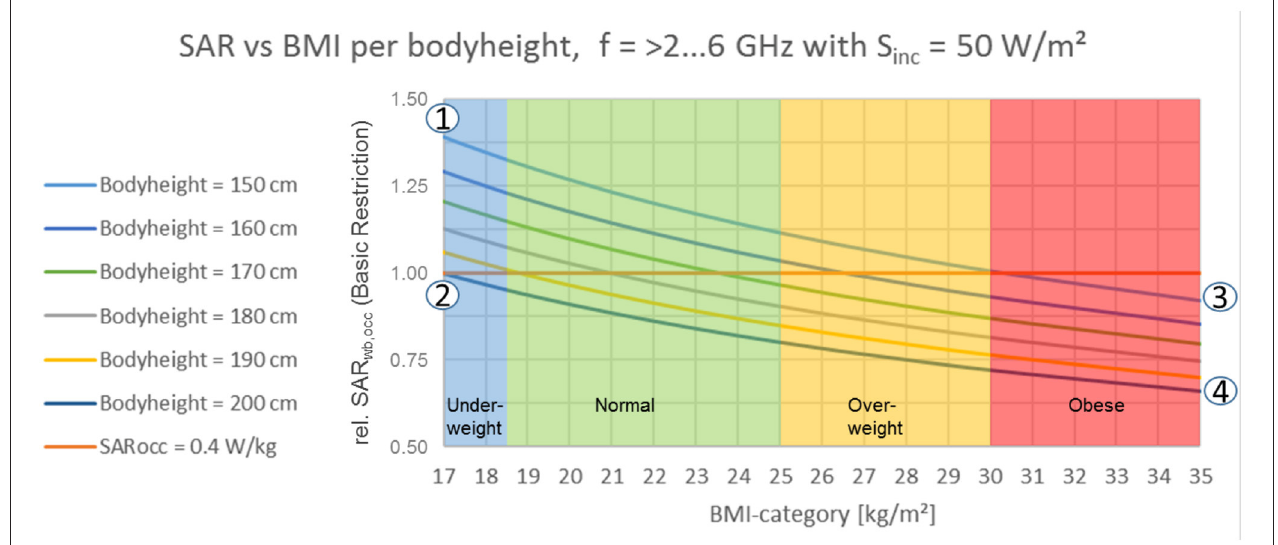
FIGURE 3 | Whole-body: effect of body height on specific absorption rate in relation to body-mass-index category for frequencies > 2–6 GHz, T avg . [according to ICNIRP 2020 ( 1) Table 5].